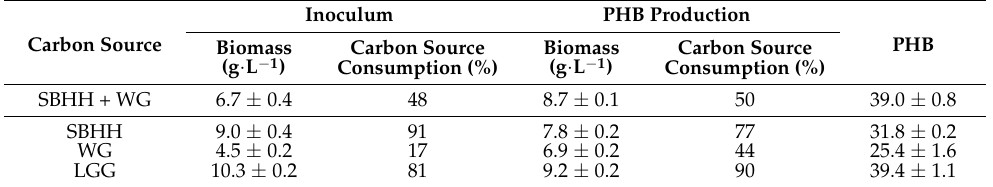
Table 4. C. necator strain DSMz 545 with different carbon sources (inoculum and production media). Carbon